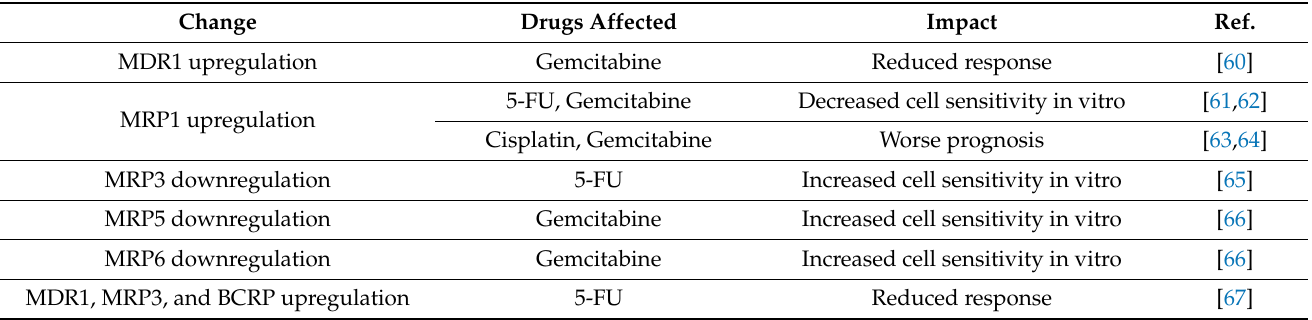
Table 3. Role of ABC proteins in chemoresistance of biliary tract cancer